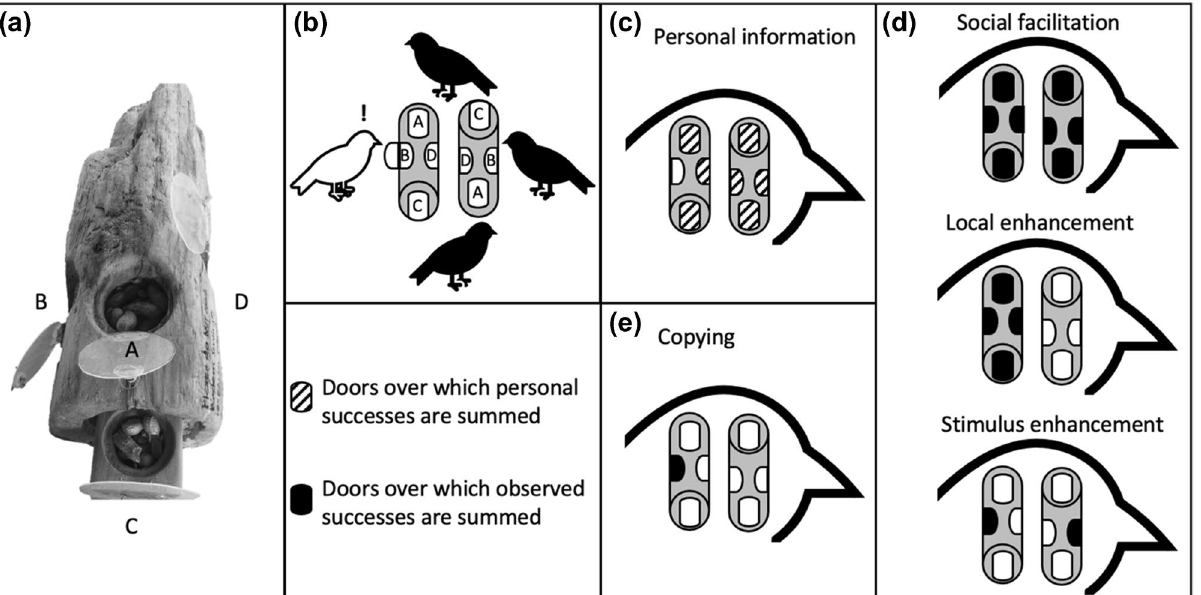
Figure 1. ( a ) Our social learning experiment involved placing food behind each of four door types on two identical apparatuses created out of logs. Doors with the same letter are the same door type and use identical locking mechanisms. ( b ) This resulted in 8 potential doors that each naïve bird (white) could attempt to open (here B door on the left apparatus). Attempts at a specific door can be motivated by ( c ) personal information from opening any of the other 7 doors, or ( d – e ) social information from observing conspecifics open any of the 8 doors. The number of observed successes at different combinations of door types and apparatus locations (left or right) are used as covariates to test for evidence of ( d ) simpler, or ( e ) the more cognitively demanding social learning mechanisms of imitation and emulation (Table 1).